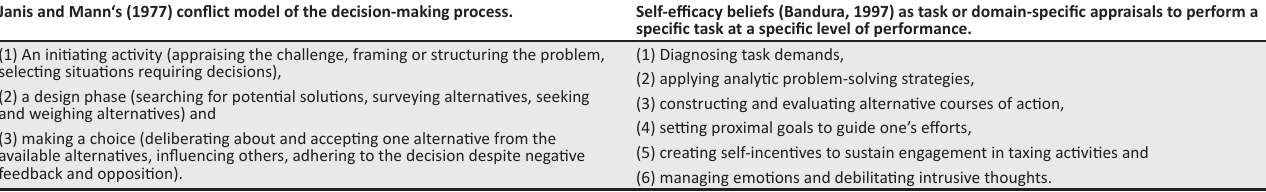
TABLE 1: Decision-making and self-efficacy beliefs. Janis and Mann‘s (1977) conflict model of the decision-making